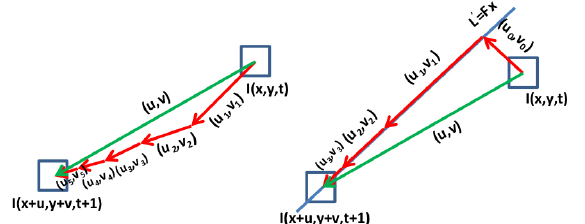
Figure 1: Optical flow estimation: Left: the Lucas-Kanade; Right: the Lucas-Kanade aided by epipolar geometry